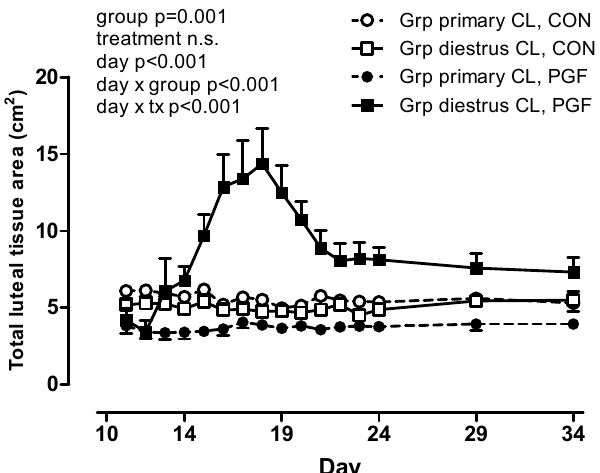
Figure 3. Total luteal tissue area (cm 2 ) in CON and PGF pregnancies with mares grouped by the absence (Grp primary CL; n = 6) or presence (Grp diestrous CL; n = 5) of a diestrous ovulation in the PGF